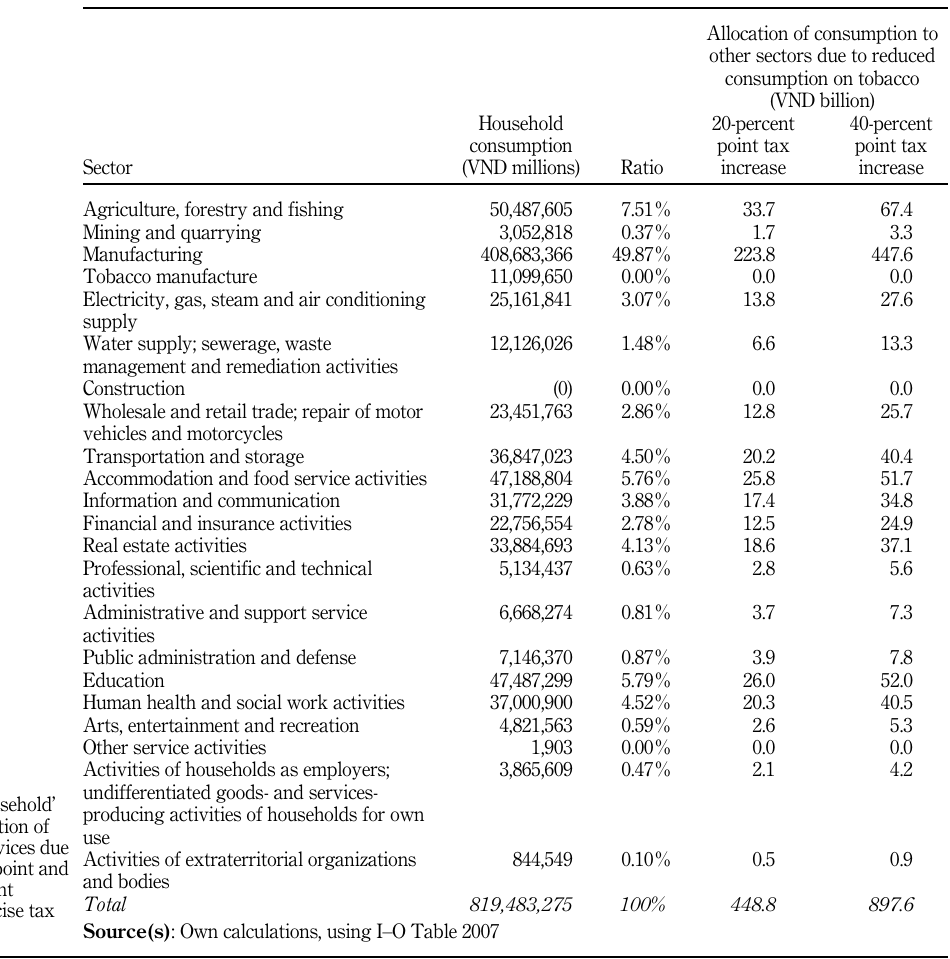
Table 2. Change in household ’ final consumption of goods and services due to 20-percent point and 40-percent point increase in excise tax on